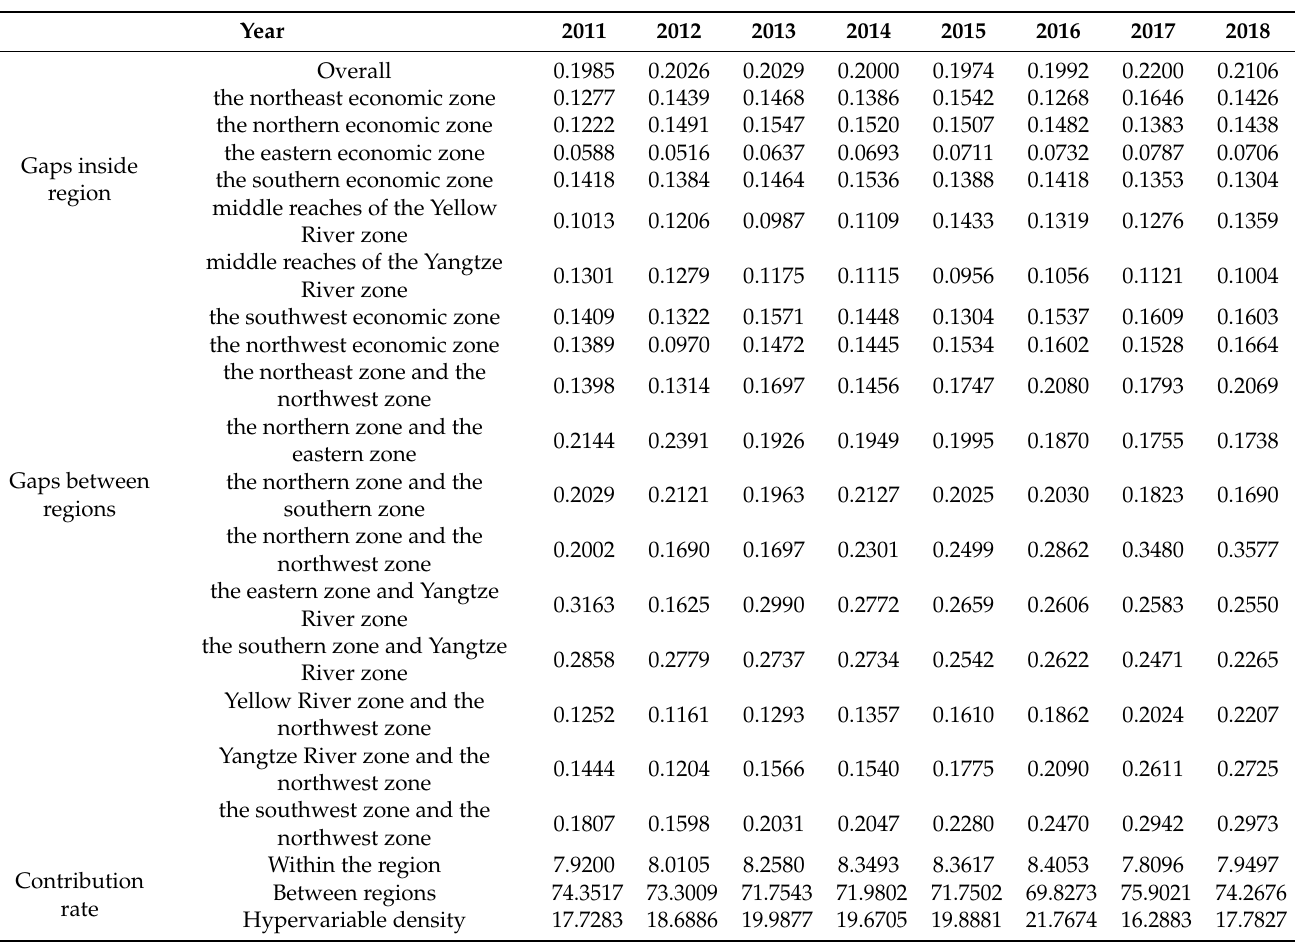
Table 7. Analysis of national and regional differences in the coupling and coordination of digital economy development and carbon emissions